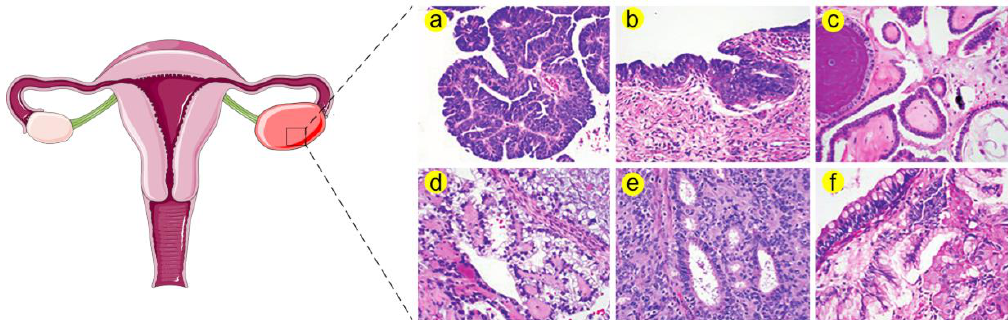
Figure 1. Histological stratification of ovarian cancer a . ( a ) High grade serous carcinoma (HGSC) is distinguished by increased nuclear atypia, high nuclear-to-cytoplasmic ratio and abundant mitosis. ( b ) Serous tubal intraepithelial carcinoma (STIC) resembles HGSC in many morphological aspects such as severe atypia, defective cellular polarity and mitoses. Therefore, STIC is believed to be a precursor of HGSC. ( c ) Low grade serous carcinoma (LGSC) is characterized by increased papillae, mild nuclear atypia and low nuclear-to-cytoplasmic ratio. ( d ) Clear cell carcinoma exhibits large tumor cell sizes and frequent clearing of the cytoplasm together with stromal hyalinization. ( e ) Endometrioid adenocarcinoma can be differentiated by gland formation that recapitulates endometrial glands. This type is further categorized according to cellular architecture and nuclear atypia. ( f ) Mucinous adenocarcinoma is characterized by increased cellular mucin and formation of goblet cells. a Histological images are adapted from Nature Reviews Disease Primers [3].